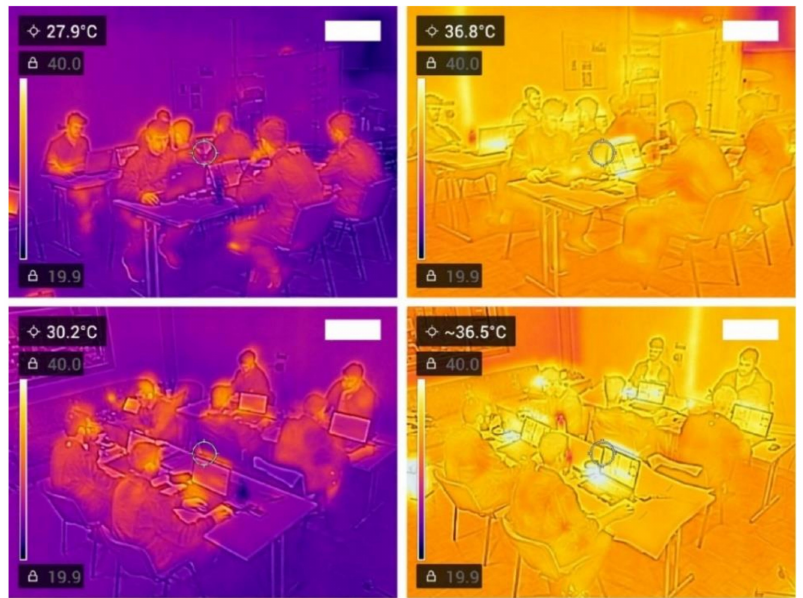
Figure 2. Ambient conditions during the day prior to the heat-wave ( left ) and the first day of the heat-wave ( right ). All pictures were taken using the same thermal camera set to be sensitive within a range of 19.9 and 40.0 ◦